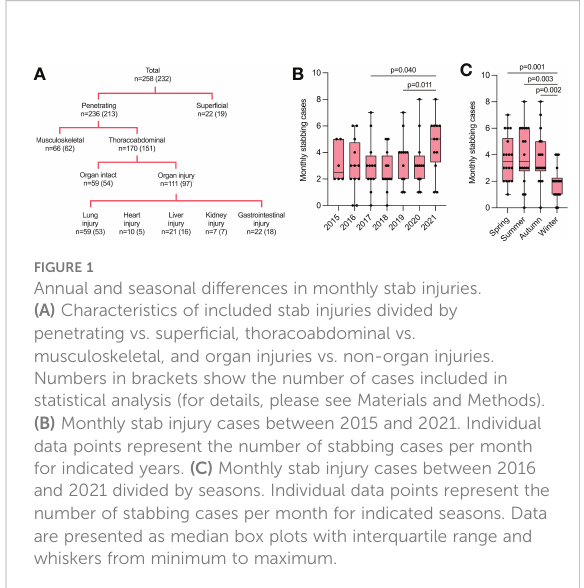
winter (spring vs. winter, p = 0.001; summer vs. winter, p = 0.003; autumn vs. winter, p = 0.002) (Figure 1C).